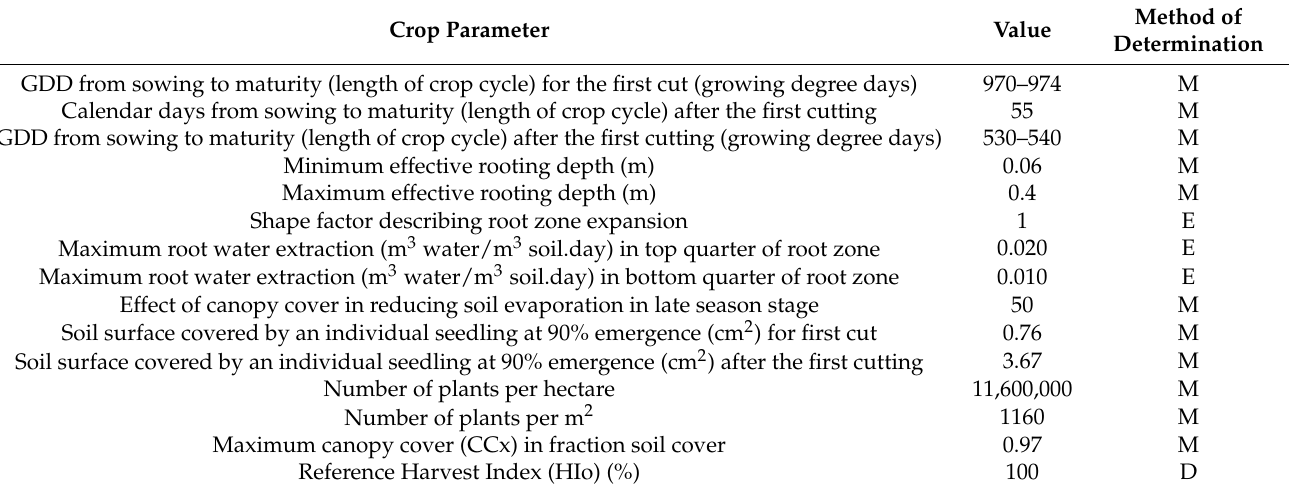
Table 6. Cont. Crop Parameter Value